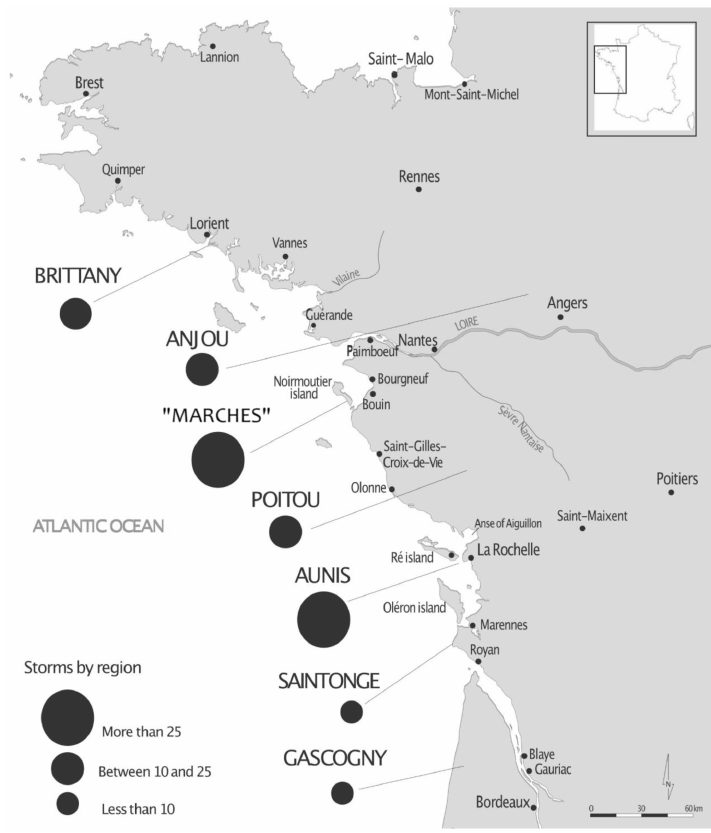
Figure 3. Map of areas subject to the risk of storms from 1300 to 1800.